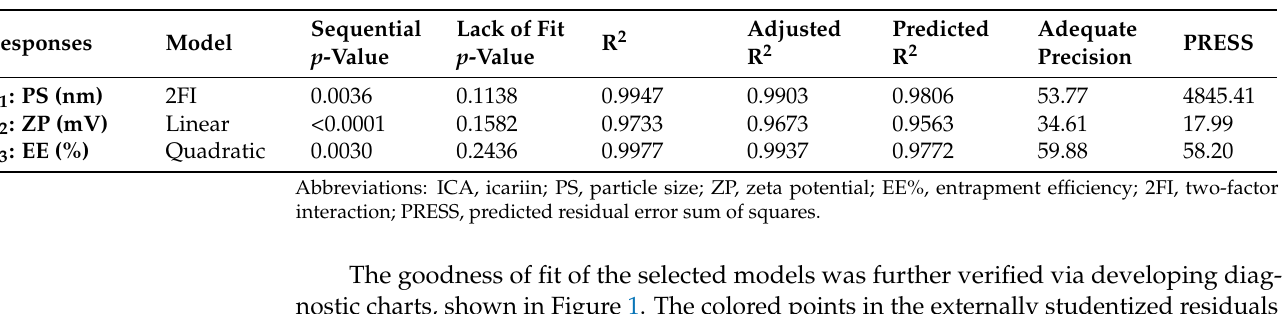
Table 3. Fit statistics of ICA–tocozeinolate nanospheres’ responses according to the best-fitting